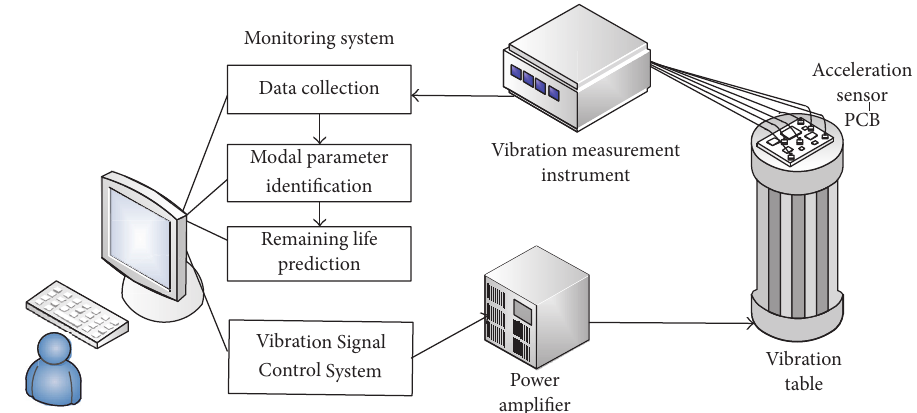
Figure 3: Monitoring devices of electronic devices under vibration.